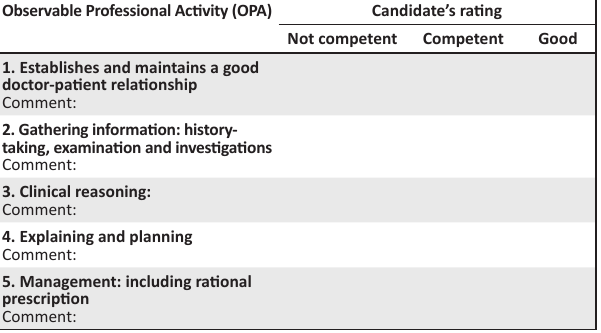
FIGURE 1: Marking template for consultation